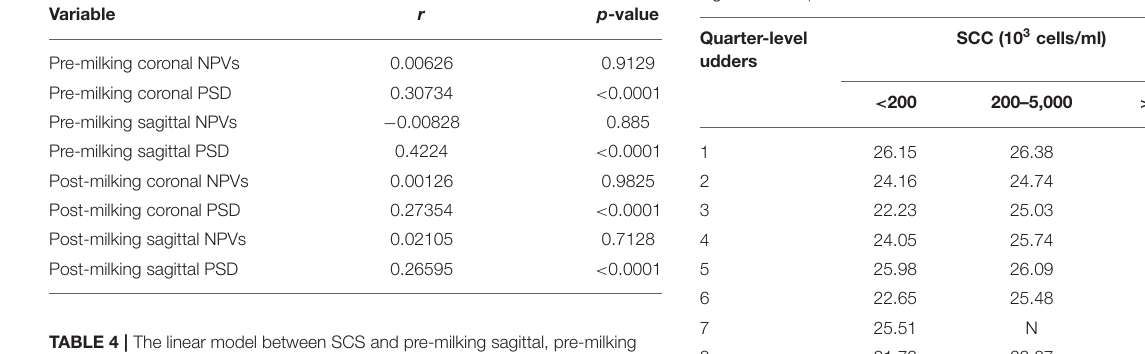
TABLE 4 | The linear model between SCS and pre-milking sagittal, pre-milking coronal PSD, post-milking coronal PSD, and post-milking sagittal PSD. Input variable